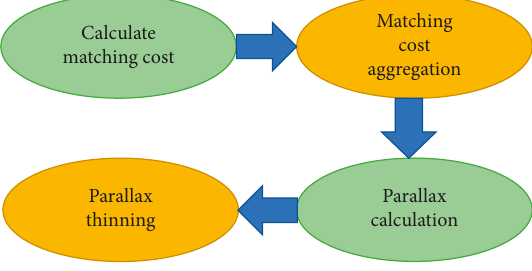
Figure 7: Steps of stereo